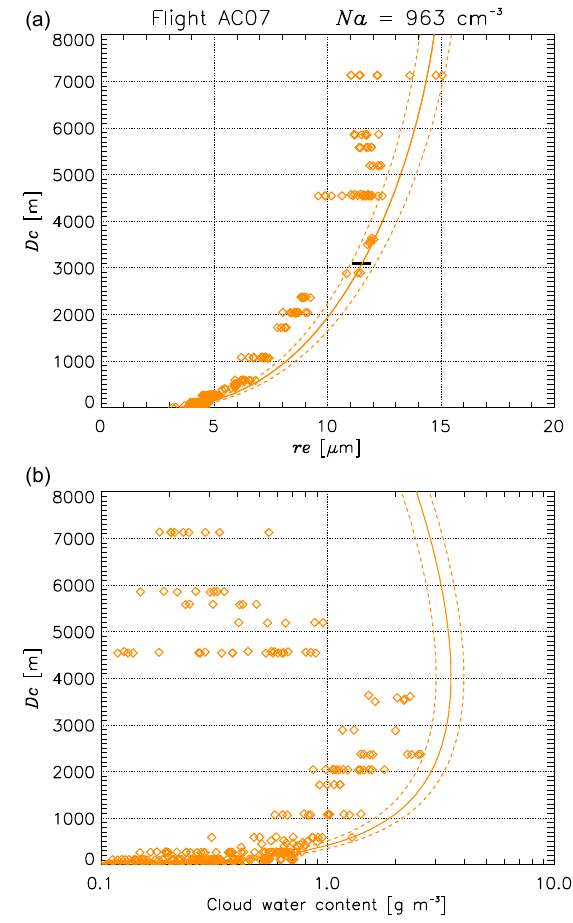
Figure 7. (a) Cloud droplet effective radius ( r e ) as a function of cloud depth ( D c ) for flight AC07. The line indicates the r e estimated for adiabatic growth ( r ea ) from cloud base (dashed lines indicate the r ea values considering the uncertainty of the estimate). The height of 0 ◦ C is indicated by a black horizontal bar across the r ea line. The estimated adiabatic number of droplets ( N a ) at cloud base is shown at the top of the figure. (b) Similar to panel (a) for cloud water content (adiabatic values are shown by